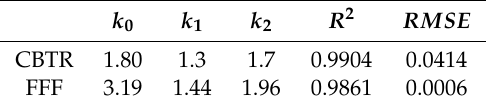
Figure 10. Percentage deviation of the predicted head loss coefficients ξ p by Equation (10) ( left ) and Equation (9) ( right ) from the measured head loss coefficients ξ m . The two rack options are highlighted in grey (CBTR) and black (FFF) and differentiated by the related blockage ratios of the rack configurations. The dashed and dotted lines represent the ± 75% and ± 25% deviation of ξ p from ξ m . Table 4. Results of the multiple linear regression analysis for Equation